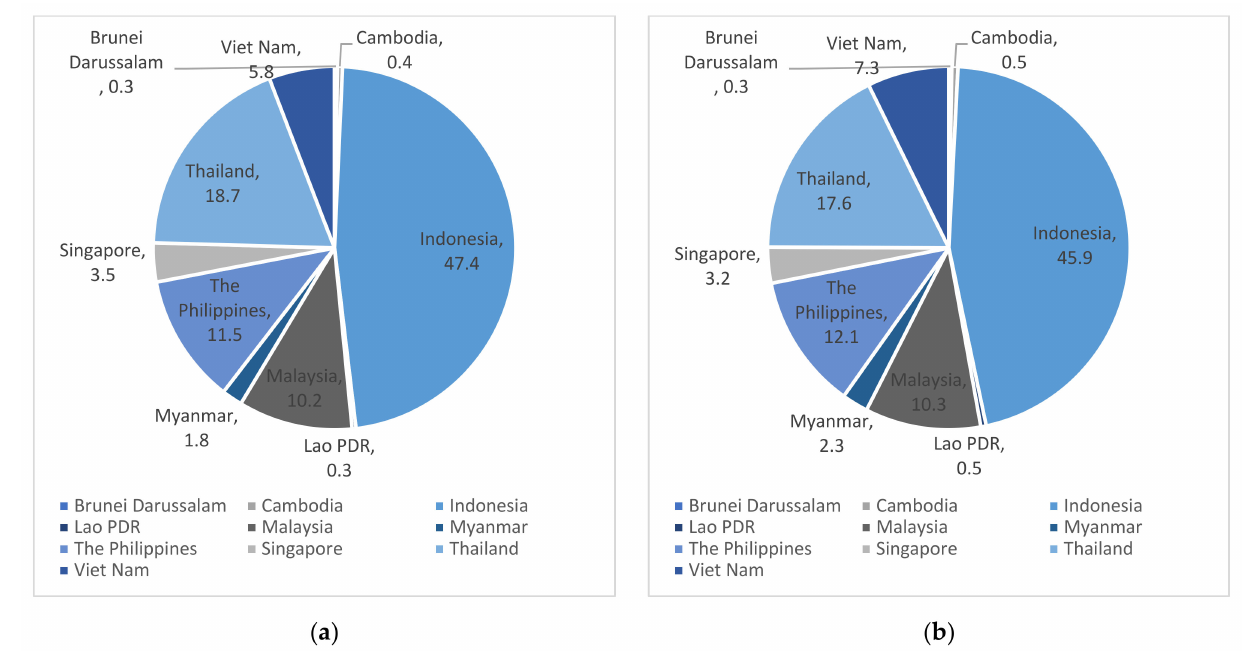
Figure 1. Shares of the E-waste generation amounts in ASEAN: ( a ) the shares in 2015; ( b ) the shares in